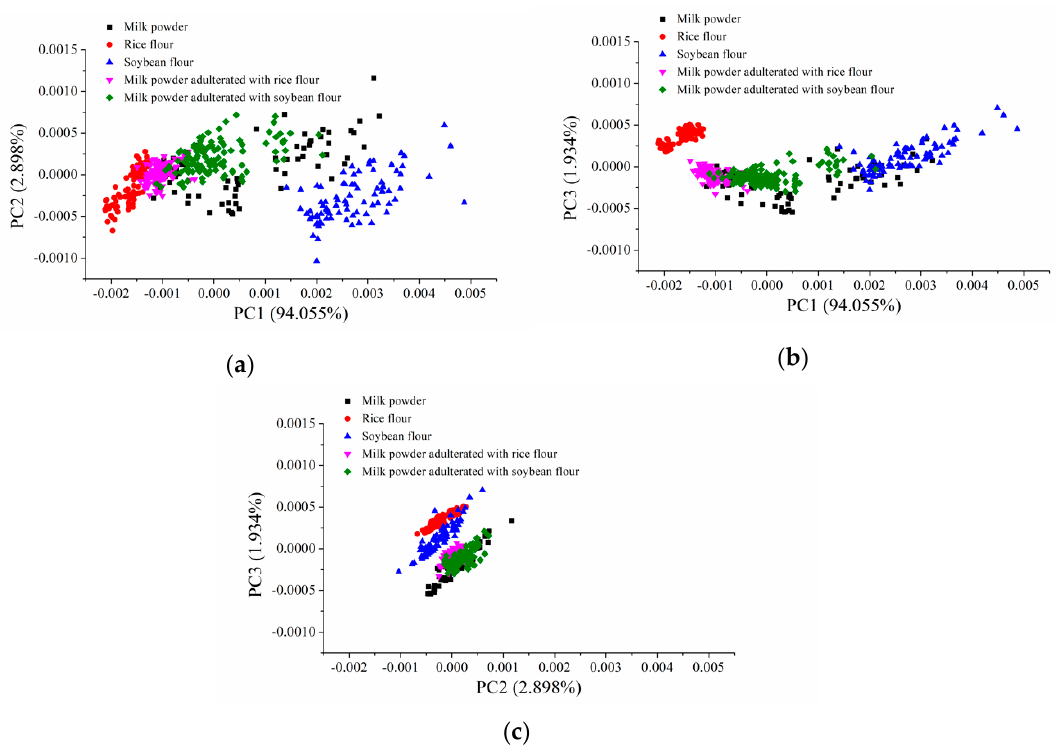
Figure 2. Scores scatter plots: ( a ) PC1 vs PC2; ( b ) PC1 vs PC3; ( c ) PC2 vs PC3. (PC means principal component). Table 3. Optimal wavenumbers selected by PCA loadings.